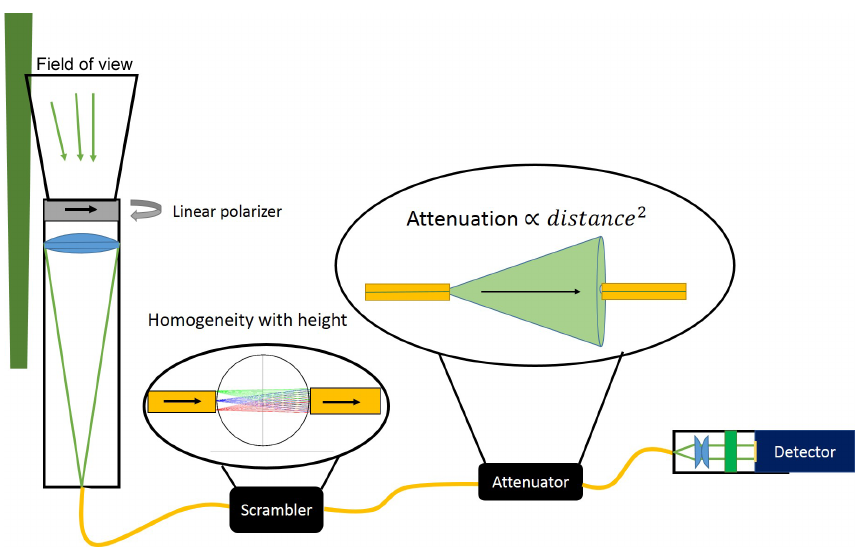
Figure 2. Sketch of one of the three identical receiver channels of the three-signal polarization lidar. The different parts are explained in the